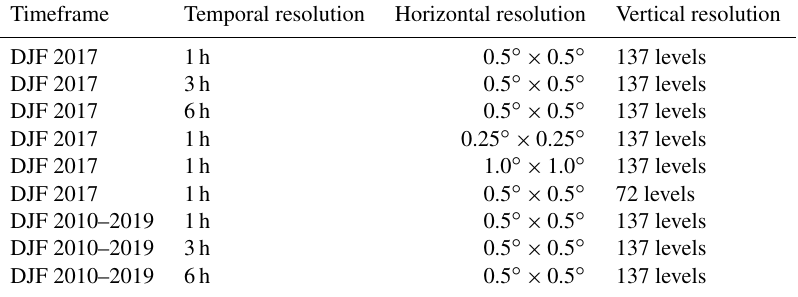
Table 1. Summary of the LAGRANTO runs used to test the sensitivity of trajectory cold points to input data resolution. All runs are with ERA5 data (Hersbach et al., 2020), which were downloaded at 1h, 0.25 ◦ × 0.25 ◦ or 0.5 ◦ × 0.5 ◦ , and 137-level resolution and subsampled or remapped using Climate Data Operators’